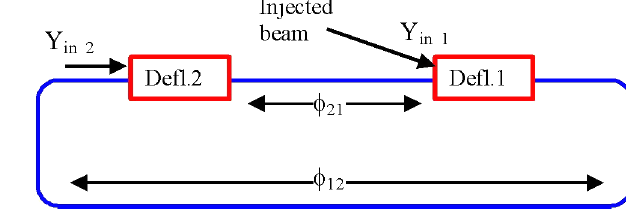
FIG. 6. Tracking code scheme.